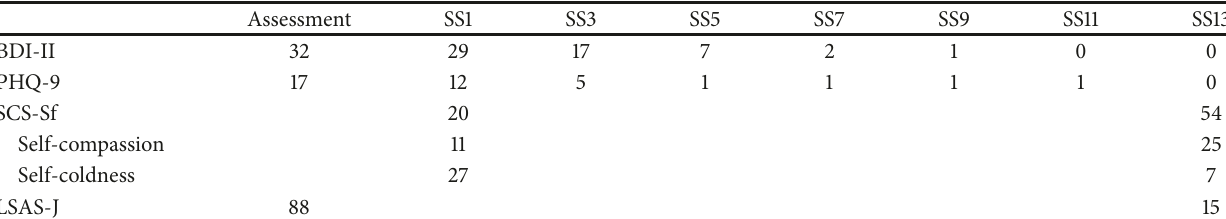
Table 1: Changes in symptoms across